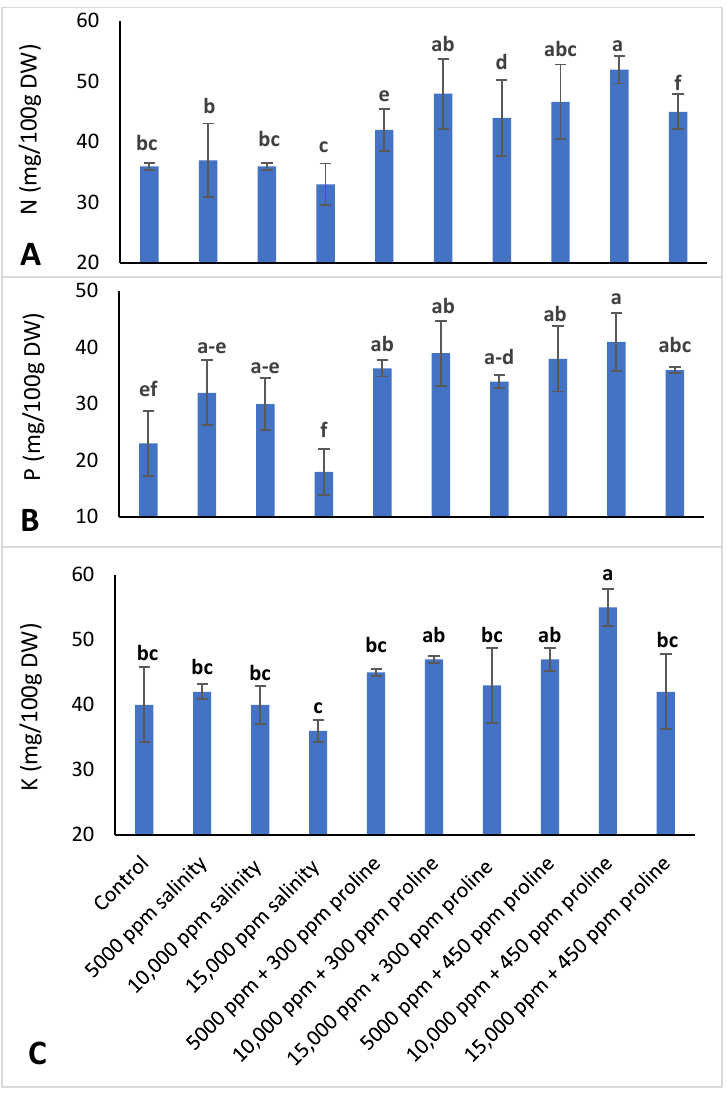
Figure 9. Effect of different levels of seawater salinity and exogenous proline at three concentrations, 0 ppm, 300 ppm, and 450 ppm, on N content (mg/100 g DW) ( A ), P content (mg/100 g DW) ( B ), and K content (mg/100 g DW) ( C ). Data are means of two seasons (2020 and 2021) and three replicates ( n = 3) each season. The mean values ± SE of each parameter followed by different alphabetical letters are significantly different according to Duncan’s multiple range test at p ≤ 0.05.